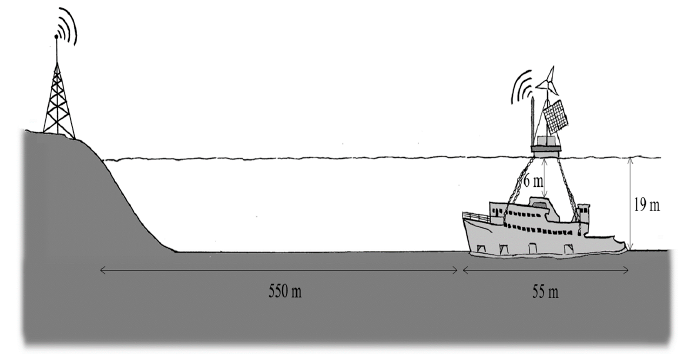
Figure 2. The sunken ferry with the pontoon above, including windmill and solar cells to power the cameras and the mobile link to land. Drawing by Sara Ortiz.